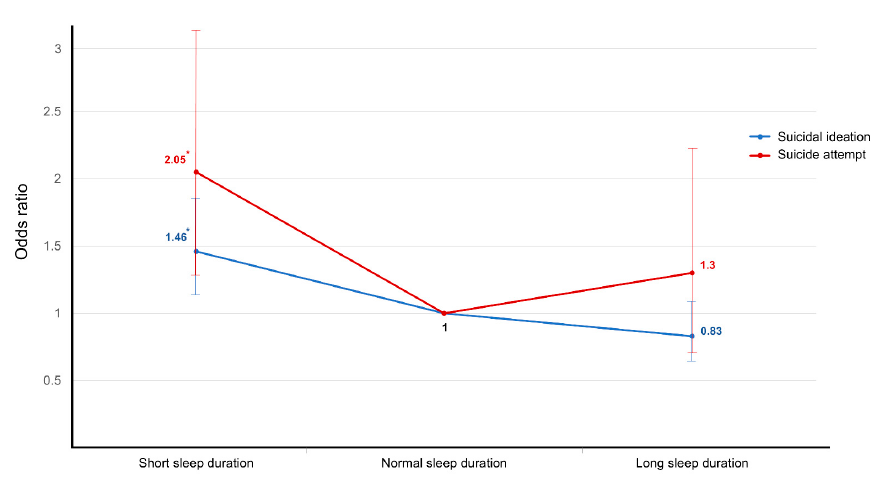
Figure 2. Association between sleep duration and suicidal ideation and suicide attempts. The logistic regression model was fully adjusted in terms of age, sex, and other environmental factors such as smoking, alcohol consumption, educational level, household income, occupation, physical activity, duration of sleep, marital status, perceived health status, depressive symptoms, and comorbidities. * p < 0.05.